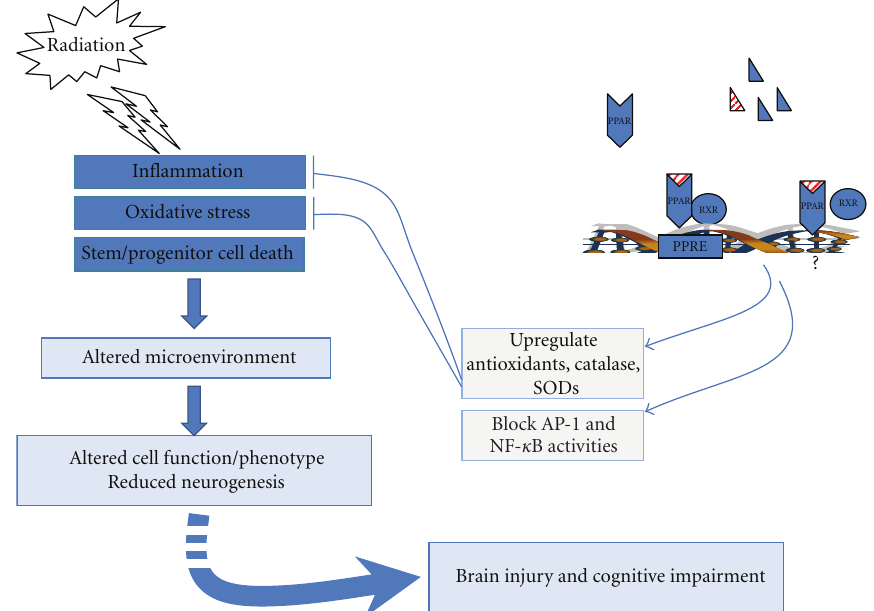
Figure 1: Model for the role of PPARs in radiation-induced brain injury. Irradiation is hypothesized to modify the brain microenvironment via the generation of an inflammatory and/or oxidative stress response which is also characterized by increased cell death of the neural precursor cells residing in the neurogenic regions of the brain. This alteration in the microenvironment is proposed to play a role in the dysfunction of the various cell-types in the brain (e.g., astrocytes, endothelial cells, microglia, neurons, and oligodendrocytes) and the reduction in ongoing adult neurogenesis ultimately contributing to radiation-induced brain injury including cognitive impairment. Activation of PPARs using specific ligands is hypothesized to play a role in normalizing the brain microenvironment and preserving cellular function following irradiation in part via inhibition of proinflammatory signaling pathways and by upregulation of antioxidant enzyme activities thus ameliorating the detrimental e ff ects of radiation on the